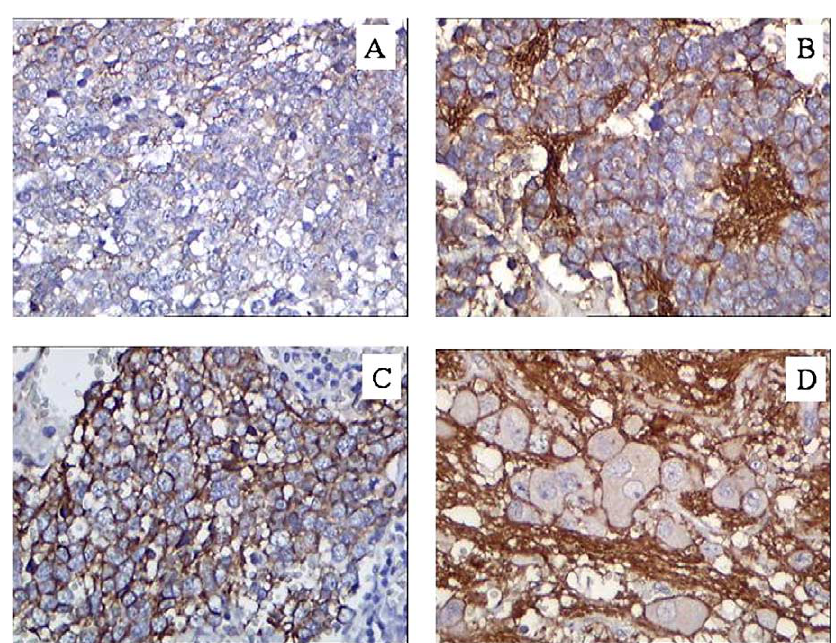
Fig. 5. Expression of ALCAM in NB primary tumors. (A) Low ALCAM expression in membrane and neuropil area. (B) Low ALCAM expression in membrane associated with high expression in neuropil area. (C) High ALCAM expression in membrane associated with low expression in neuropil area. (D) High ALCAM expression in membrane and neuropil